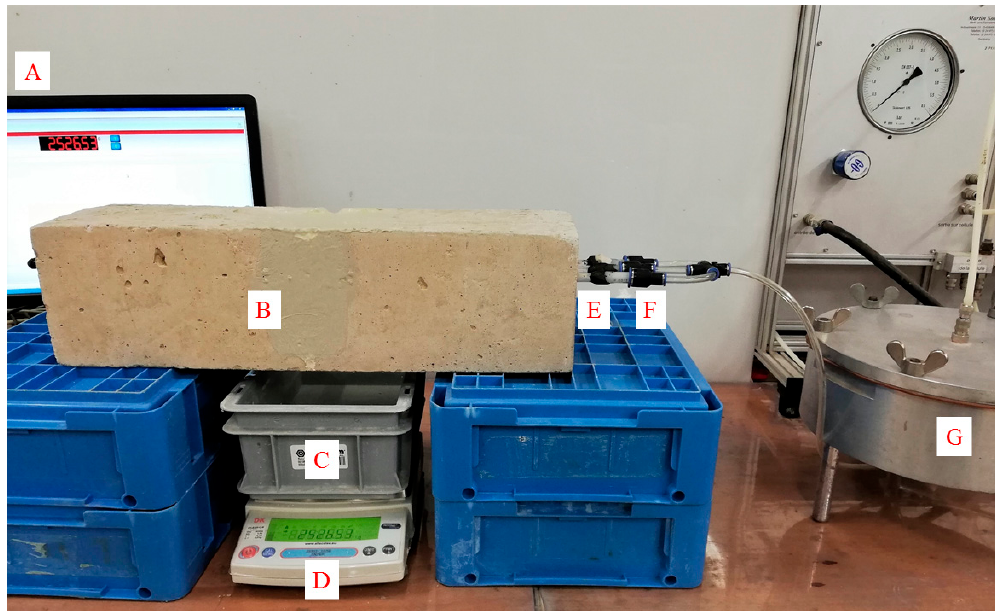
Figure 8. Water permeability setup (A: computer recording the weight measured by the scale, B: epoxy to seal the lateral side of the specimen, C: container to capture the water leaking out of the crack from the bottom side of the specimen, D: scale, E: glass tubes which run along the entire length of the specimen, F: connection of the glass tubes to a pressurized water reservoir via flexible tubing, and G: pressurized reservoir).